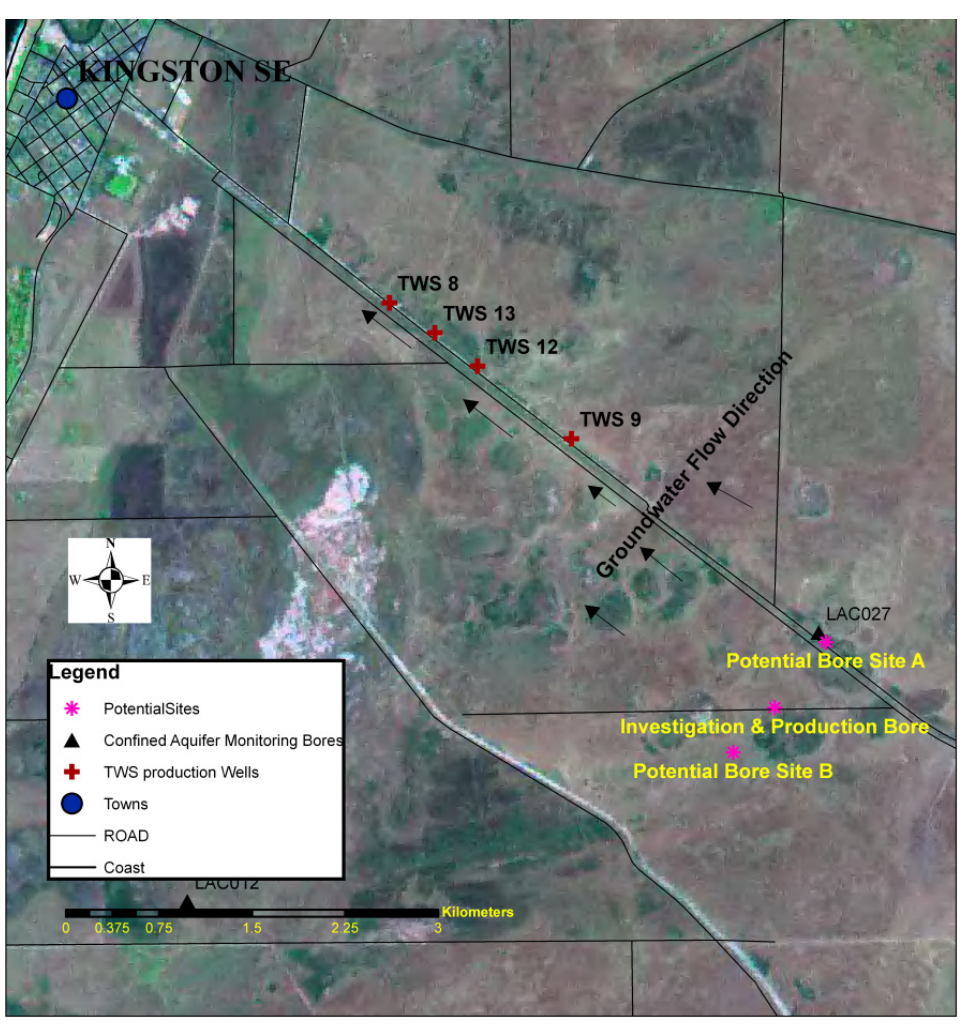
Figure 10. Layout of the Kingston South East (SE) wellfield.